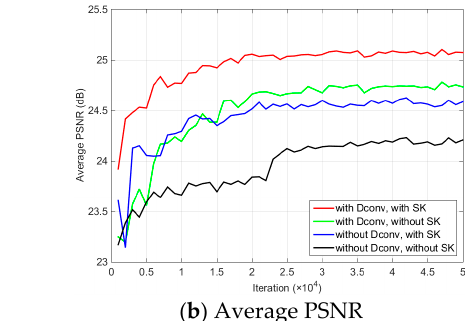
( f ) Figure 11. Filtered images for the San Francisco SAR image contaminated by four-look speckle. ( a ) Original image. ( b ) PPB [13]. ( c ) SAR-BM3D [14]. ( d ) SAR-POTDF [16]. ( e ) SAR-CNN [28]. ( f ) SAR-DRN. Table 5. ENL results for the Flevoland and Deathvalley images. Data